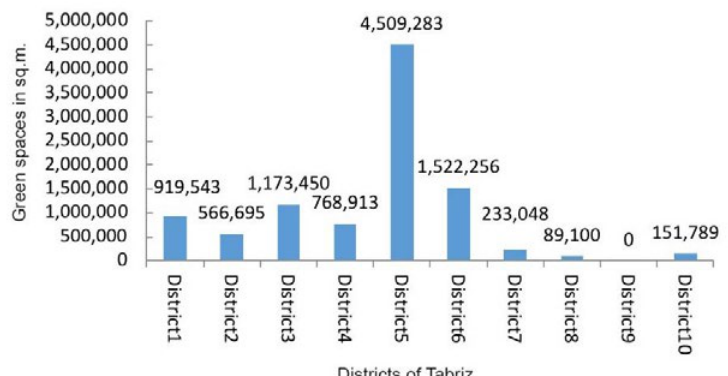
Fig. 2: Level of green space change to other land uses in the municipal districts from 1996 to 2016